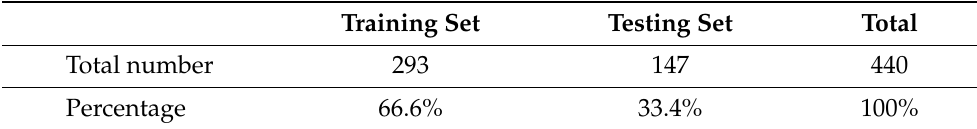
Table 3. Division of the experimental RCS messages.